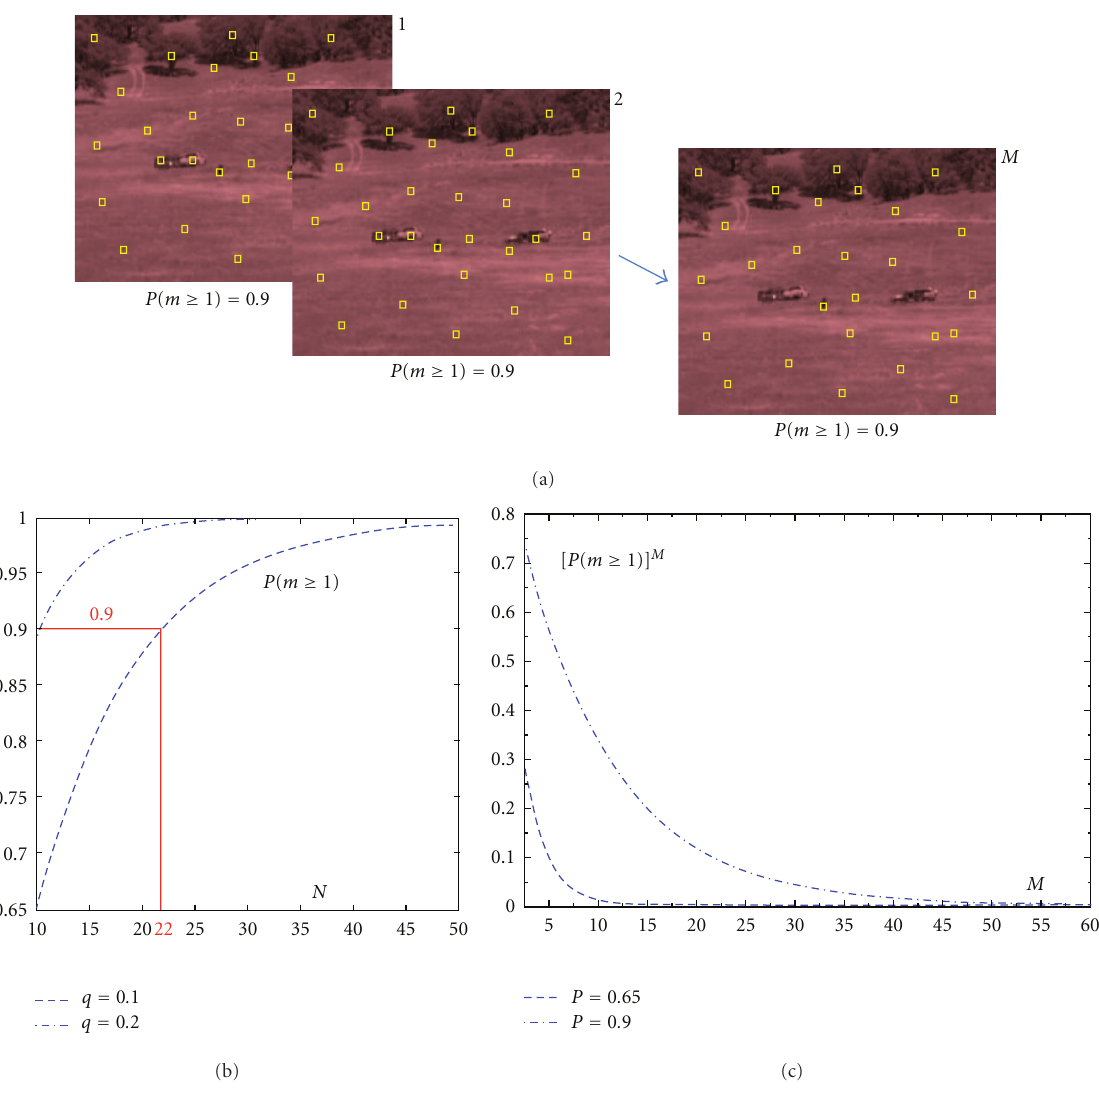
Figure 7: The relationship between N (the number of randomly selected blocks of data, shown as yellow squares on the imagery) and the contamination probability P g ( m ≥ 1) = P ( m ≥ 1) is shown in (b) for a given q (e.g., q = 0 . 10), which is an upper bound guess representing the maximum ratio between target pixels over the R × C area. To better characterize the unknown clutter background, a high N is most desired, but at a high cost, that is, an undesirably high P g ( m ≥ 1). The overall contamination probability, however, can significantly decrease by independently repeating the random sampling process M number of times, as shown (c) of figure, and then fusing results using a suitable